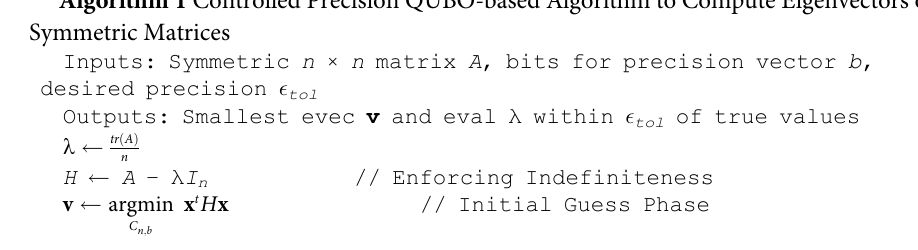
Algorithm 1 Controlled Precision QUBO-based Algorithm to Compute Eigenvectors of Symmetric